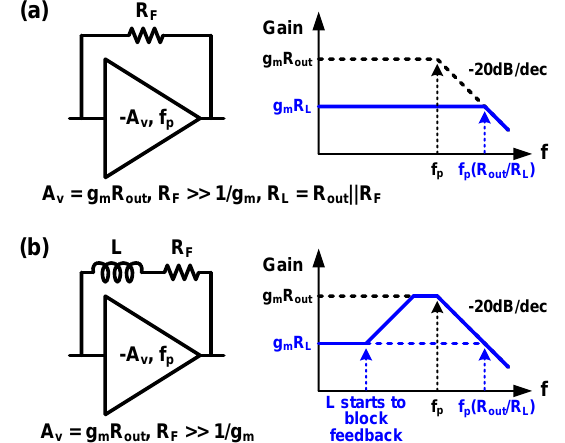
Figure 35. Effect of feedback on the transfer function of an amplifier ( a ) with only resistive feedback ( b ) with the combination of resistive and inductive feedback.